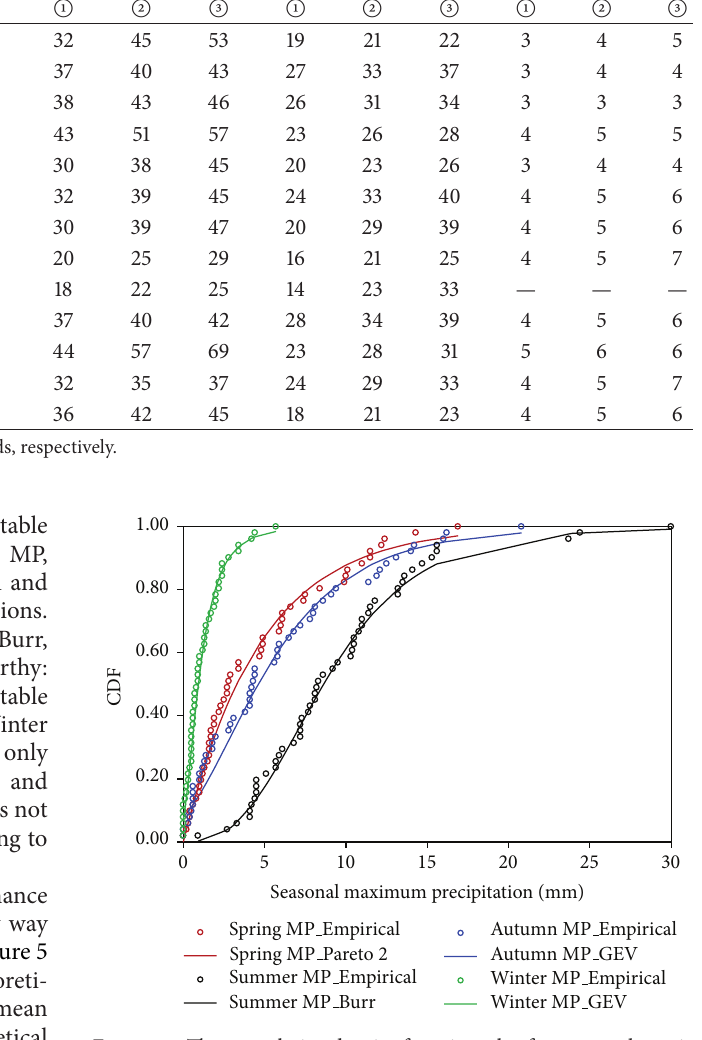
Figure 5: The cumulative density function plot for seasonal maxi- mum precipitation of DX station by using the best fitted probability